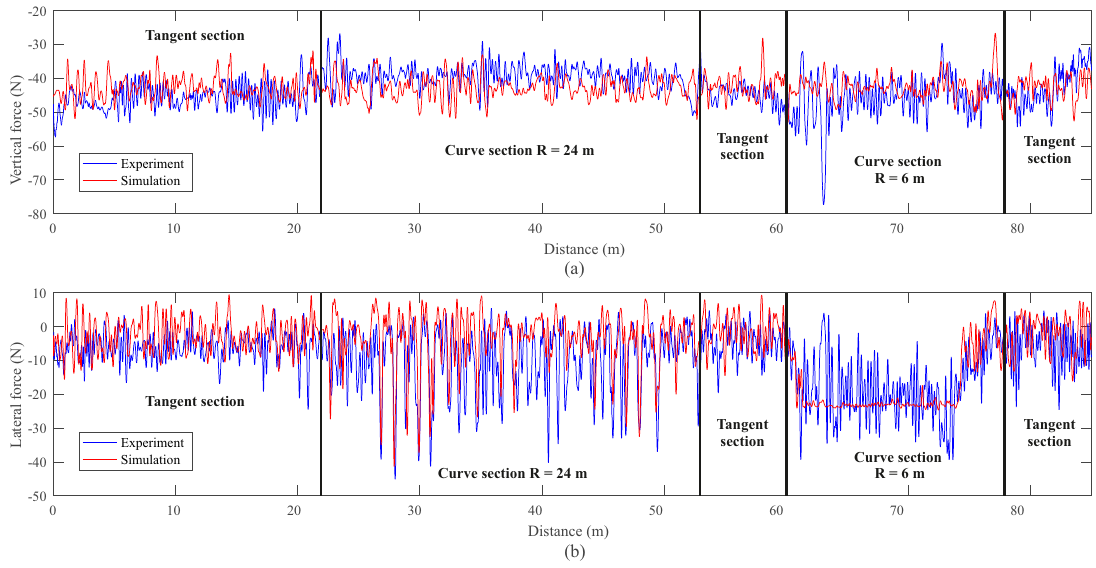
Figure 21. Instrumented wheel vertical ( a ) and lateral ( b ) applied